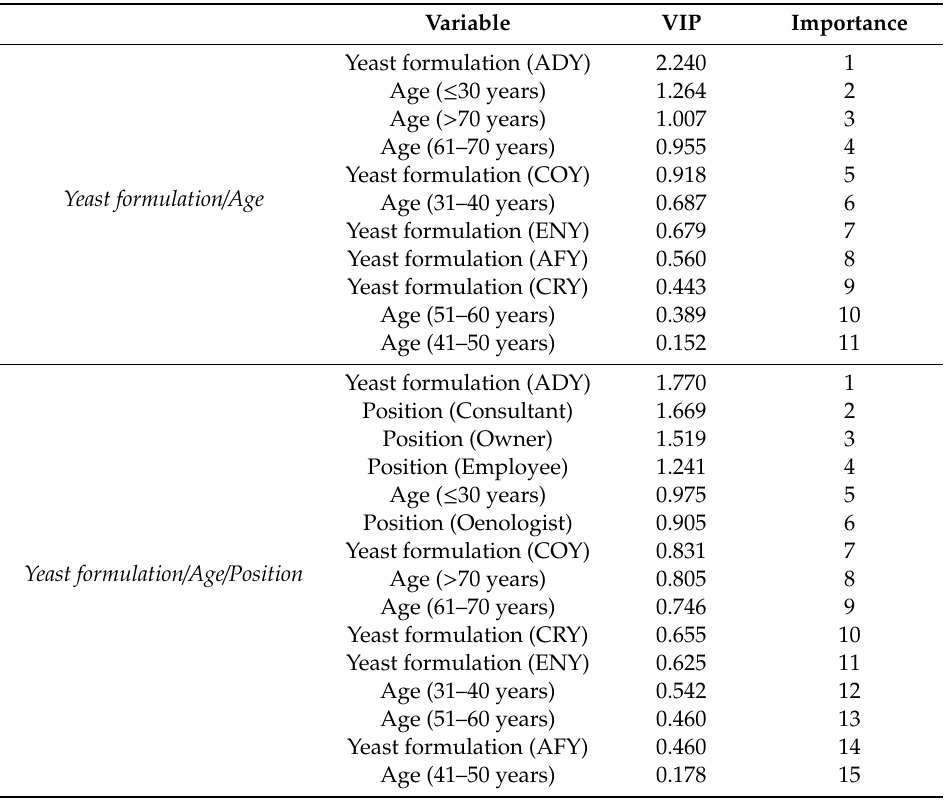
Table 2. Variable importance projection (VIP) scores obtained by the partial least square